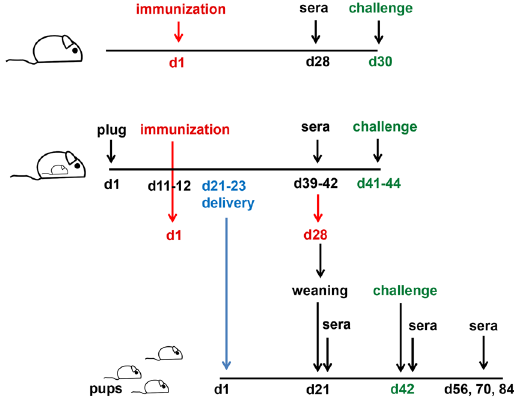
Figure 6. Schematic presentation of animal vaccination and challenge. Pregnant BALB/c mice were immunized at mid gestation with A/Brisbane/59/07 H1N1 vaccine via the intramuscular (IM), intradermal (IM), or cutaneous route using fish gelatin microneedles encapsulating the vaccine (MN). Non-pregnant female mice were also immunized with the same vaccine via the same routes. On day 28 after immunization mice were bled and then challenged with homologous virus. The pups were weaned three weeks after birth and bled on weeks 3, 4, 5, 6, 8, 10, and 12. A group of 6 week old pups was challenged with A/Brisbane/59/07 H1N1 virus 6 weeks after